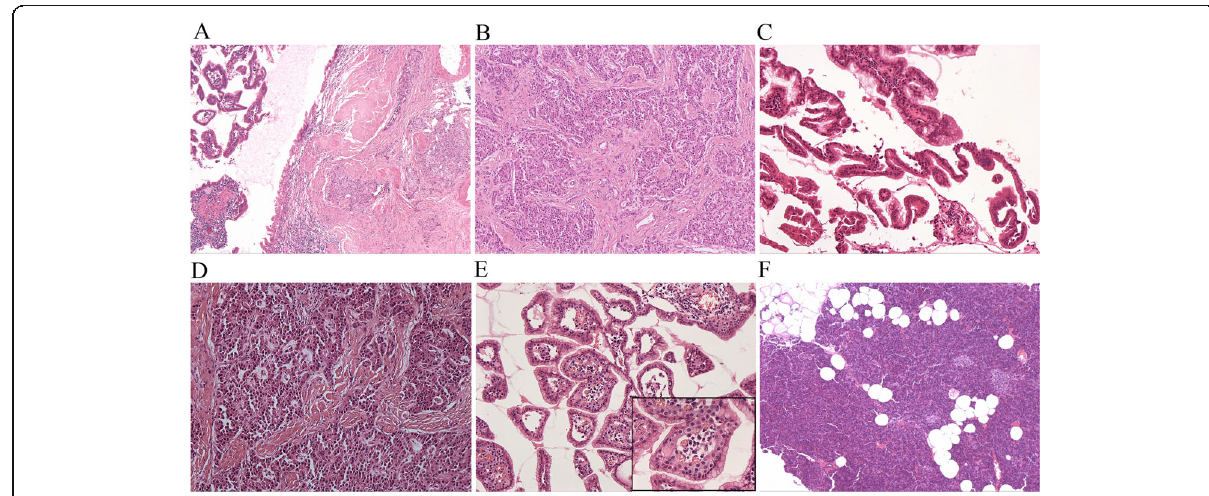
Fig. 3 A Mixed areas of IPMN (left) and NET (right) components (HEx40). ( B ) Relative separate NET component (HEx40). ( C ) Relative separate IPMN component was composed of papillae covered by epithelial cells with mild to moderate dysplasia (HEx100). ( D ) Relative separate NET component showed the NET cells had round to oval nuclei. Few mitoses were found (HEx100). ( E ) In mixed areas, the papillae were lined with epithelial cells of IPMN, and filled with clusters of NET nests in the stroma (HEx100). Inset: Composite IPMN-NET. ( F ) Pancreatic tissue in the background was relatively normal